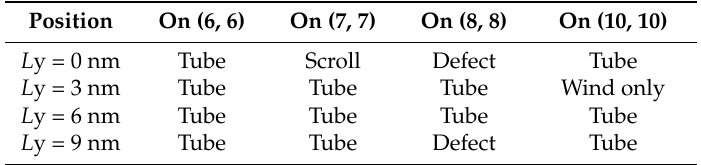
Table 3. Final states of the BP on different CNTs with α = − 30 ◦ , but different initial positions. “Scroll” means the BP ribbon winds upon the CNT and forms into a scroll.